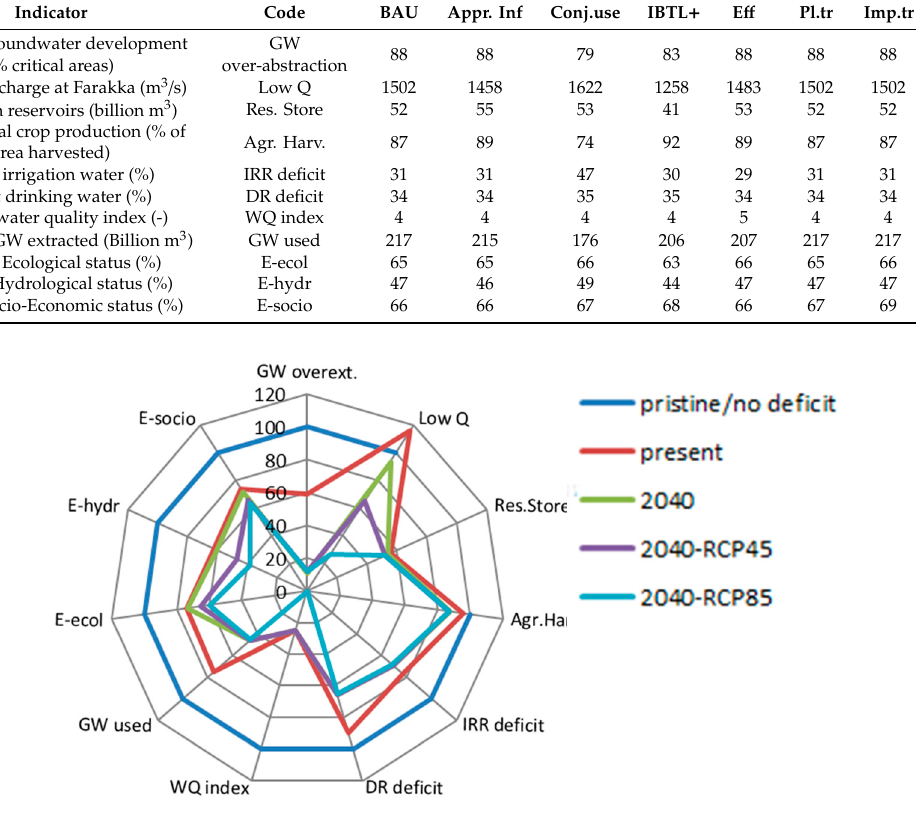
Figure 9. Basin-wide indicators for five scenarios. Values are scaled from 0 to 100, with the pristine scenario as 100). Indicator codes are explained in Table 6 and described in Table 2.